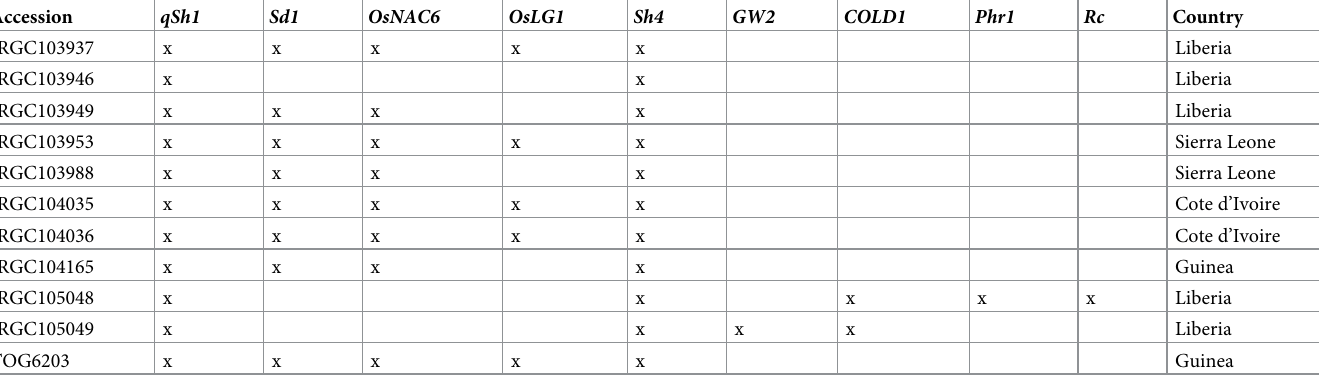
Table 3. OG-II accessions possessing a different haplotype than the main O . glaberrima clade in multiple domestication genes. All these accessions have in common that they cluster with OB-B rather than OB-C and OB-D and share a single haplotype with other O . glaberrima individuals for the genes that are marked with an